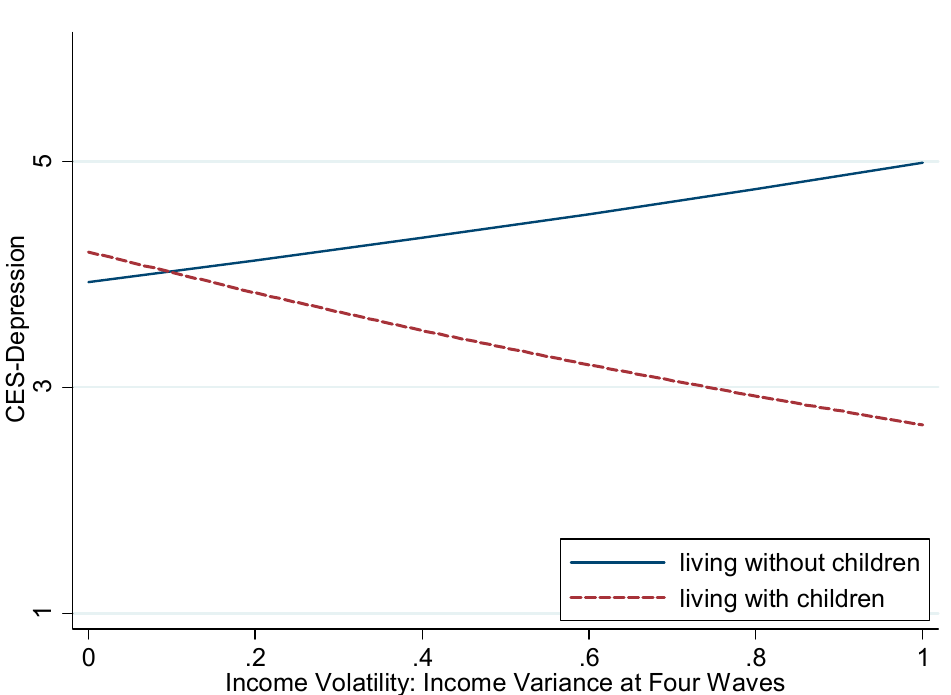
Figure 1. The predicted Center for Epidemiologic Studies-Depression (CES-D) 10 scores across income volatility by co-residence with children in full sample. Significantly different relationship between income volatility and CES-D 10 scores by living with children ( p -value of interaction term (between income volatility and living with children) <0.001, p -value of Wald test <0.001).